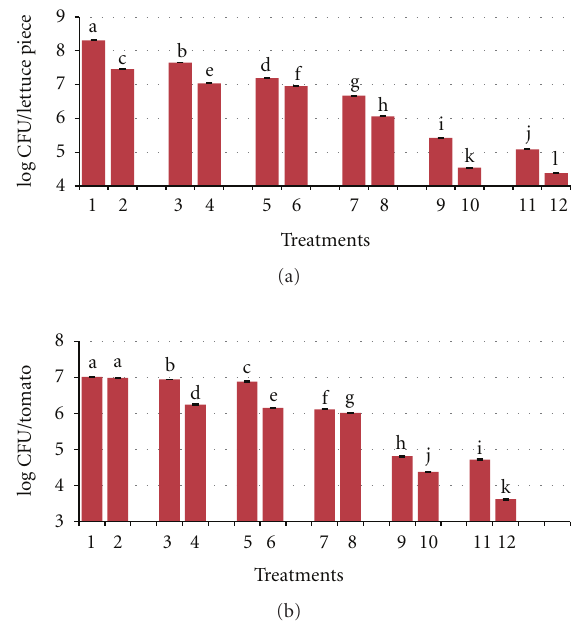
Figure 1: Populations of E. coli O157:H7 on the surface of (a) lettuce and (b) tomato samples treated with copper (Cu) and lactic acid (La) solution with and without Tween 80 (T80) as surfactant. The error bars represent the standard deviations for replicate samples. Means with di ff erent letters over the error bars are significantly di ff erent ( P < 0 . 05). (1) Control, (2) Tween 80, (3) Cu 20ppm, (4) Cu 20ppm + T80, (5) Cu 40ppm, (6) Cu 40ppm + T80, (7) La 0.2%, (8) La 0.2% + T80, (9) La 0.2% + Cu 20ppm, (10) La 0.2% + Cu 20ppm + T80, (11) La 0.2% + Cu 40 ppm, and (12) La 0.2% + Cu 40 ppm +